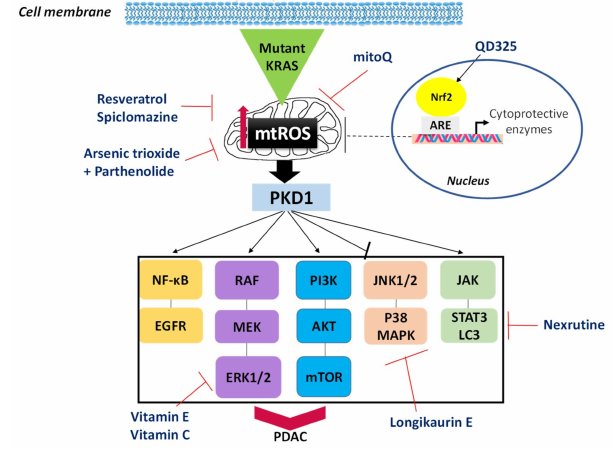
Figure 2. Mutant KRAS-driven signaling pathways via mitochondrial ROS-induced activation of protein kinase D1 (mtROS/PKD1), and potential options for therapeutic intervention in pancreatic cancer. Activation of PKD1 is mediated by increase in mtROS promoted by mutant Kras expression. ROS-activated PKD1 promotes cell survival by inactivating JNK1/2 and p38 signaling, and activating NF- κ B and EGFR signaling. PKD1 also promotes proliferation by up-regulating ERK1/2 and PI3K. To prevent PDAC development, one possibility is to use antioxidant therapies like vitamins E and C, longikaurin E, nexrutine, and mitoQ. In a therapeutical context, some drugs can induce ROS accumu- lation and apoptosis such as resveratrol, spiclomazine, arsenic trioxide combined with parthenolide, and QD325 through Nrf2-mediated oxidative stress. Abbreviations: ARE, antioxidant response element; Akt, protein kinase B; EGFR, epidermal growth factor receptor; ERK1/2, extracellular- regulated kinase 1/2; JAK, Janus kinases; JNK 1/2, c-Jun N-terminal kinase 1/2; LC3, light chain 3; MAPK, mitogen activated-protein kinase; MEK, mitogen-activated protein kinase; mTOR, mechanis- tic (previously mammalian) target of rapamycine; mtROS, mitochondrial reactive oxygen species; NF- κ B, nuclear factor kappa-light-chain-enhancer of activated B cells; Nrf2, nuclear factor erythroid 2-related factor 2; PDAC, pancreatic ductal adenocarcinoma; PI3K, phosphatidylinositol-3 kinase; PKD1, protein kinase D1; RAF, rapidly accelerated fibrosarcoma; STAT3, signal transducer and activator of transcription protein